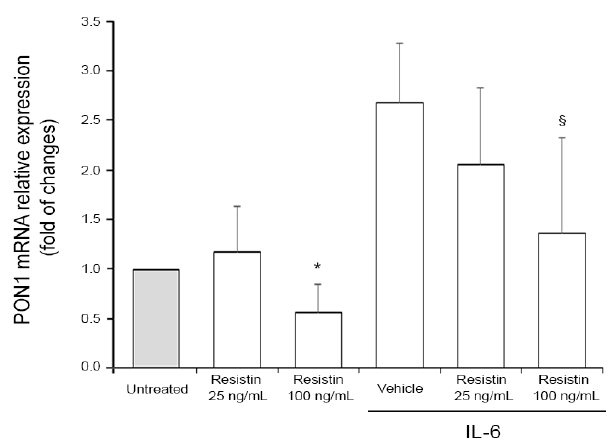
Figure 1. Resistin modulates PON1 expression in vitro in HEP 3B2.1-7 cells. Cell cultures were exposed to human resistin (at the indicated concentrations) for 24 h alone or in combination with IL-6 (10 ng / mL). PON1 mRNA expression was analyzed by qRT-PCR and expressed as fold of change with respect to Untreated cultures set at 1. Results are reported as mean ± SD of three independent experiments. * p < 0.05 vs. untreated; § p < 0.06 vs. vehicle.